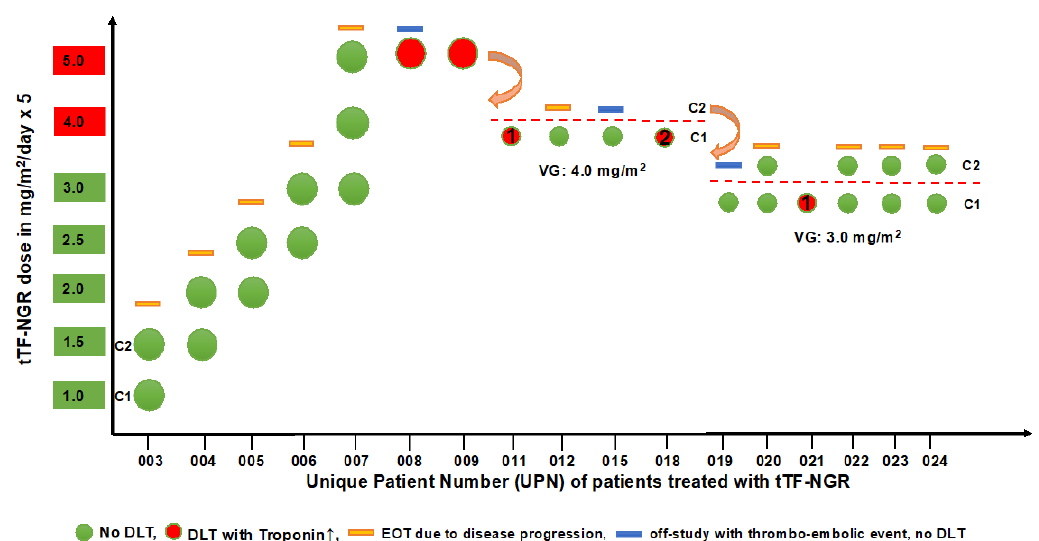
Figure 1. Distribution of all patients treated and cycles of tTF-NGR given over the dose range studied. UPN, unique patient number; for further information, see Table 1; C, cycle; EOT, end of treatment; DLT, dose limiting toxicity; VG, verification group.